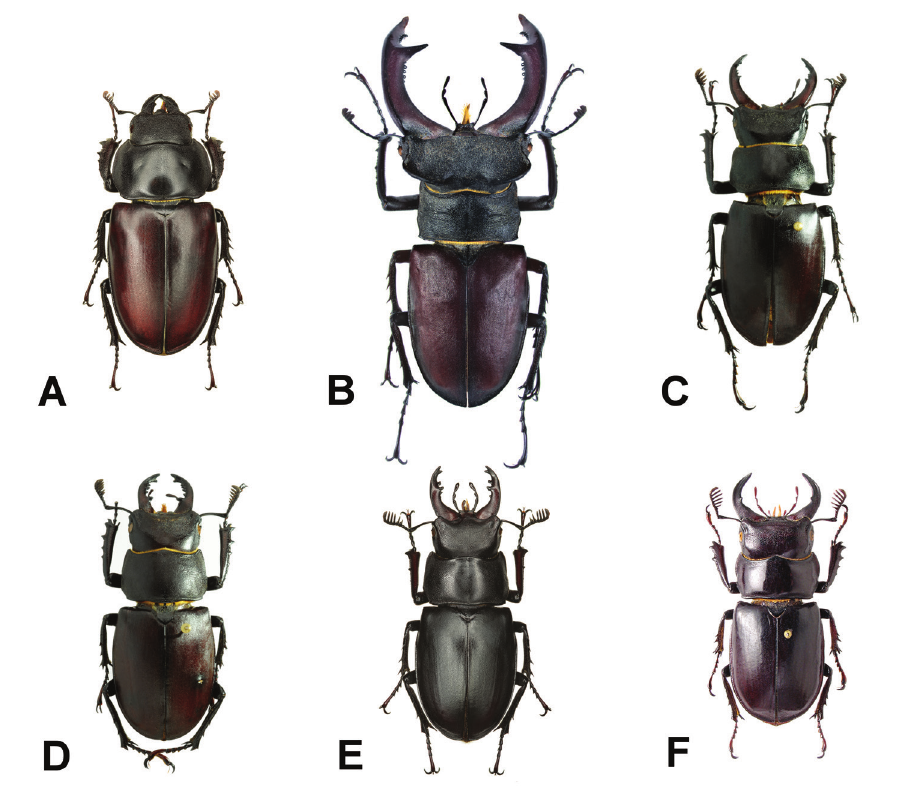
Figure 1. The five European species of Lucanus : A L. cervus female (Dresden, Germany; photo by I. Belousov) B L. cervus male (Schweinfurt, Germany; photo by U. Schmidt) C L. pontbrianti male (La Cadière, France; photo by S. Bambi and L. Bartolozzi) D L. tetraodon male (Cosenza province, Italy; photo by S. Bambi and L. Bartolozzi) E L. ibericus male (Dagestan, Russia; photo by I. Belousov) F L. barbarossa male (N Spain; photo by M.